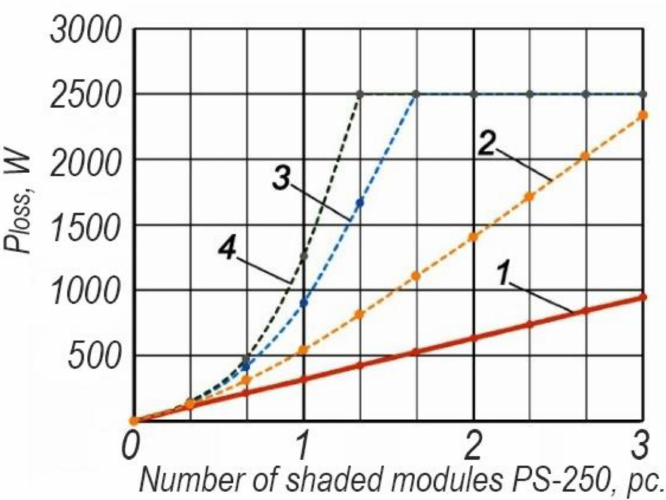
Figure 11. Graph of the dependence of the power losses of a PV battery on the partial shading of PV modules of one of the solar cell arrays (1—with APE; 2—consisting of three arrays of solar cells and installation of MPPT in AMP; 3—consisting of 10 arrays of solar cells and the installation of MPPT in AMP; 4—installing MPPT in LMP).